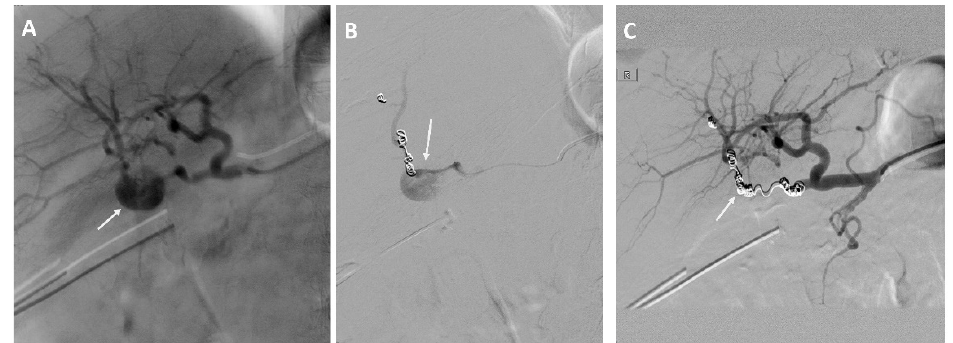
Figure 2. A 73-year-old woman with a history of intraductal papillary mucinous cancer of the pan- creatic head and pylorus preserving pancreatoduodectomy (PPPD). ( A , B ) Angiography showing bleeding from the superior mesenteric artery. ( C ) Treatment of the superior mesenteric artery with a stent-graft.